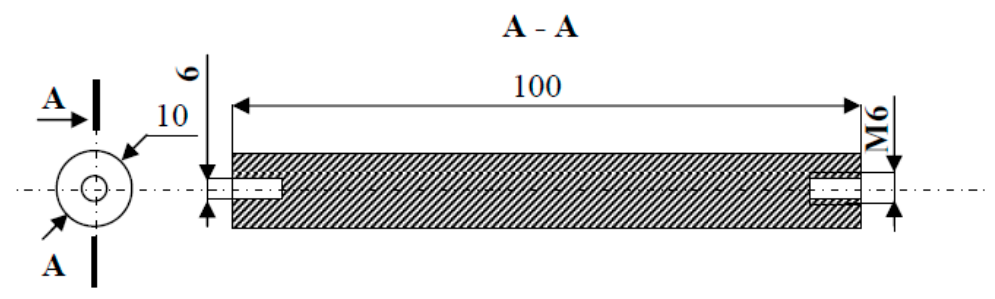
Figure 4. The shape and dimensions of the electrode made of gold.